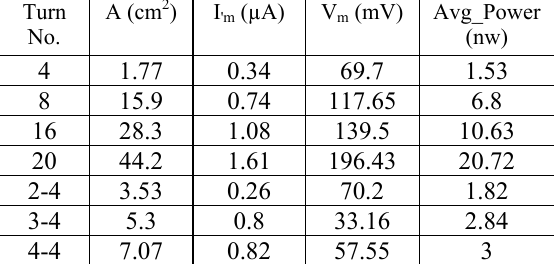
Table 1. Summary of the measurement and calculation results for the fabricated TENG samples with different turn numbers and different numbers of parallel